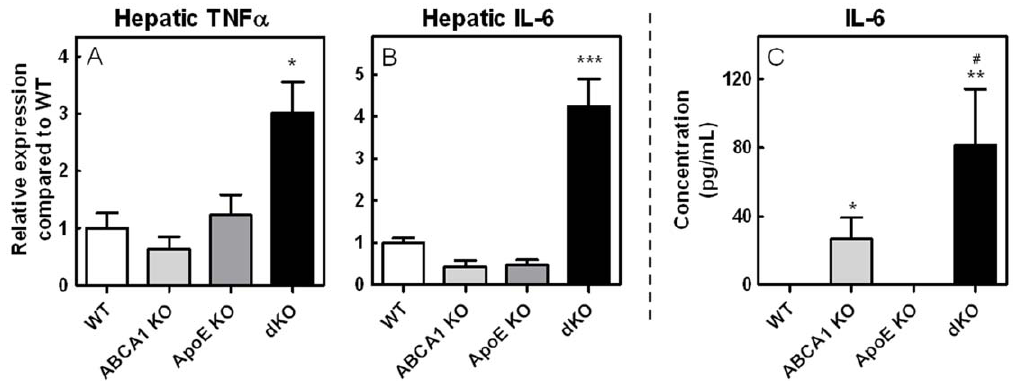
Figure 8. Hepatic gene expression levels and circulating IL-6 levels. mRNA expression of TNF a (A), and IL-6 (B) in liver from bone marrow transplanted LDLr KO mice. Gene expression analysis was performed by RT-PCR. Values are relative to the average expression of housekeeping genes and expressed as fold induction compared to WT transplanted controls. Values are mean 6 SEM, n $ 3 mice per group as compared to WT. Increased circulating IL-6 levels in LDLr KO mice transplanted with ABCA1/apoE double KO bone marrow (C). Serum from the transplanted LDLr KO mice was collected at 17 weeks after transplantation including 9 weeks of WTD feeding. Values are mean 6 SEM, n $ 8 mice per group. *p , 0.05, **p , 0.01. ***p , 0.001 as compared to WT transplanted controls. # p , 0.05 as compared to ABCA1 KO transplanted